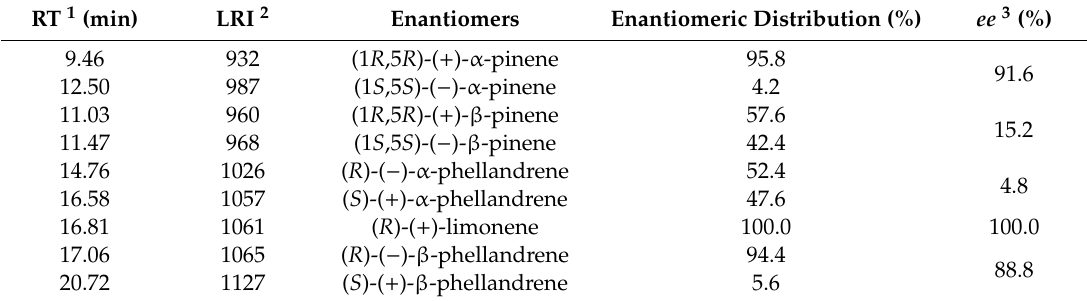
Table 2. Enantioselective analysis of some chiral constituents of D. mutisii EO with 2,3-diethyl- 6- tert -butyldimethylsilyl- β -cyclodextrin column.